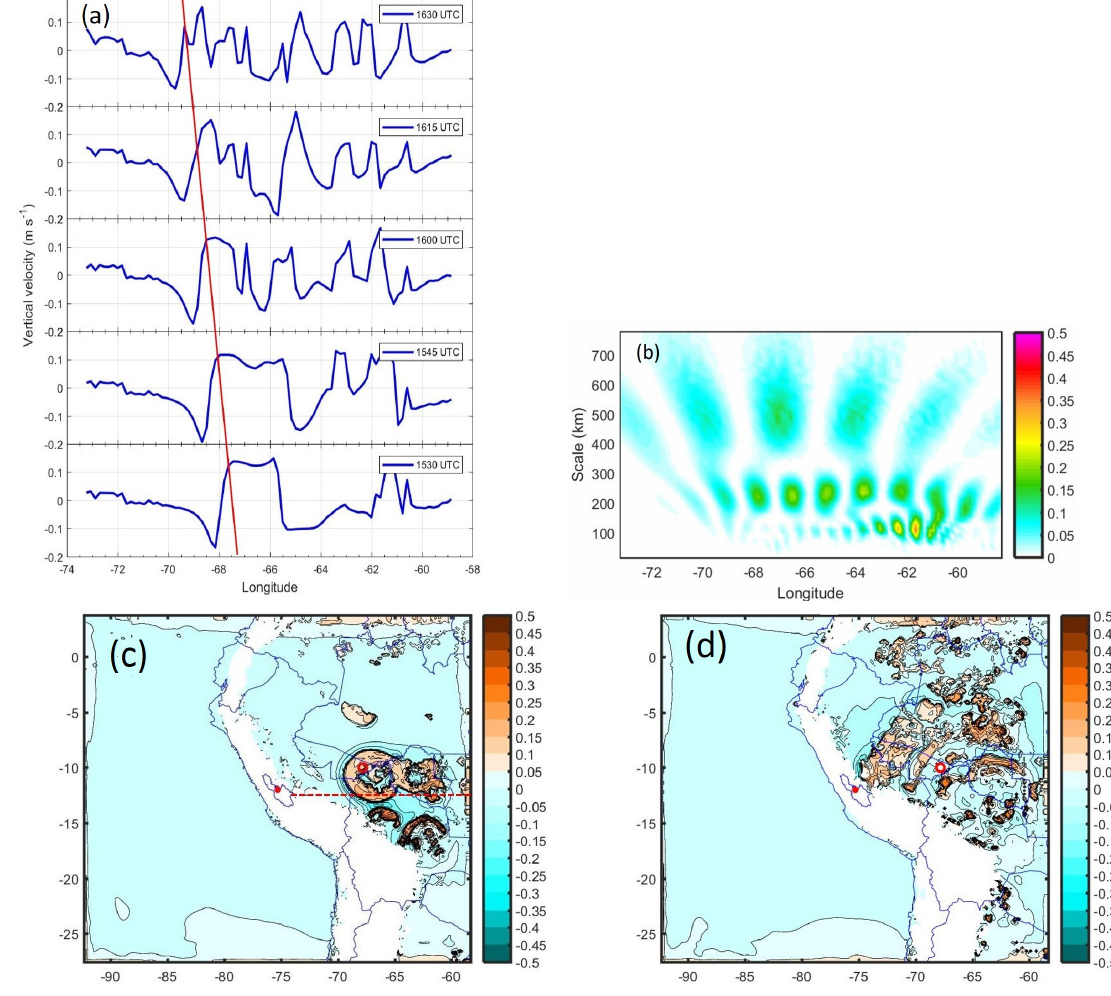
Figure 12. ( a ) Zonal and time variability of vertical wind speed ( w bp , m s − 1 ) at 600 hPa. The data were obtained from the model WRF (resolution: 18 km) for the convective event TS1 at 1530, 1545, 16, 1615, 1630 UTC (1030, 1045, 11, 1115,1145 LT). ( b ) Morlet CWT for ( w bp , m s − 1 ) at 16 UTC (11 LT); Horizontal section of vertical velocity at 450 hPa for the convective event TS1 at ( c ) 1545 UTC (1045 LT) and ( d ) 2015 UTC (1515 LT). The full circle indicates the location of the Huancayo observatory (12.05 ◦ S, 75.32 ◦ W, 3313 m